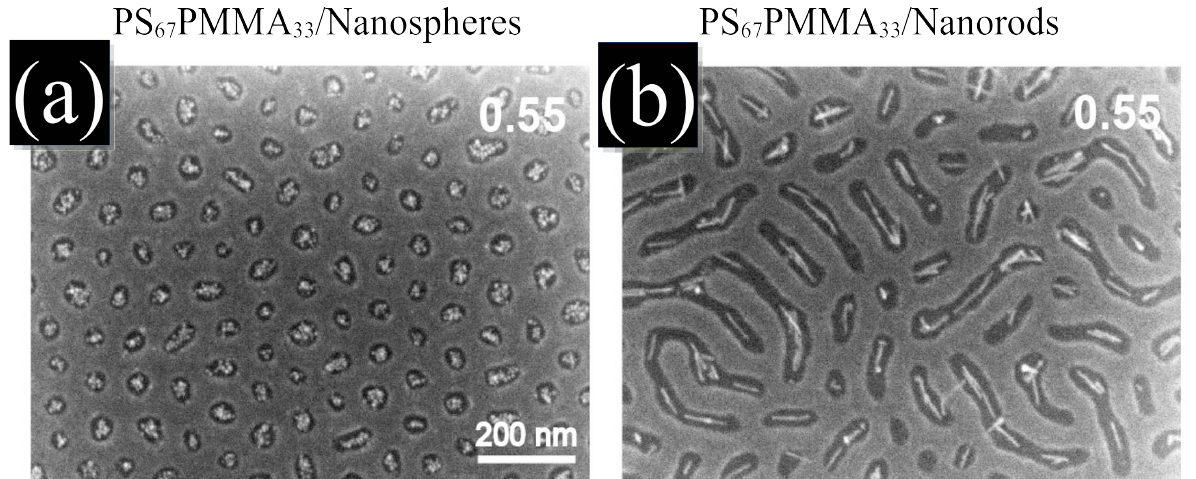
Figure 1. High-resolution SEM images of the coassembly of asymmetric PS- b -PMMA thin film with two NP shapes: ( a ) nanospheres and ( b ) NRs, with the same volume fraction of NPs φ p = 0.3. NPs are compatibilised with the PS domains. The scale bar is the same in both images. Adapted with permission from Ref. [56]. Copyright 2014 American Chemical